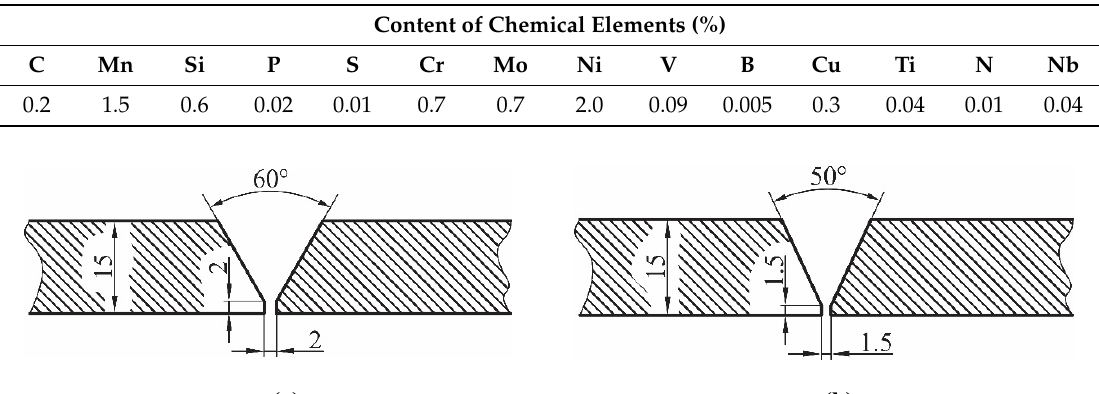
Table 1. The chemical composition of S690 steel.